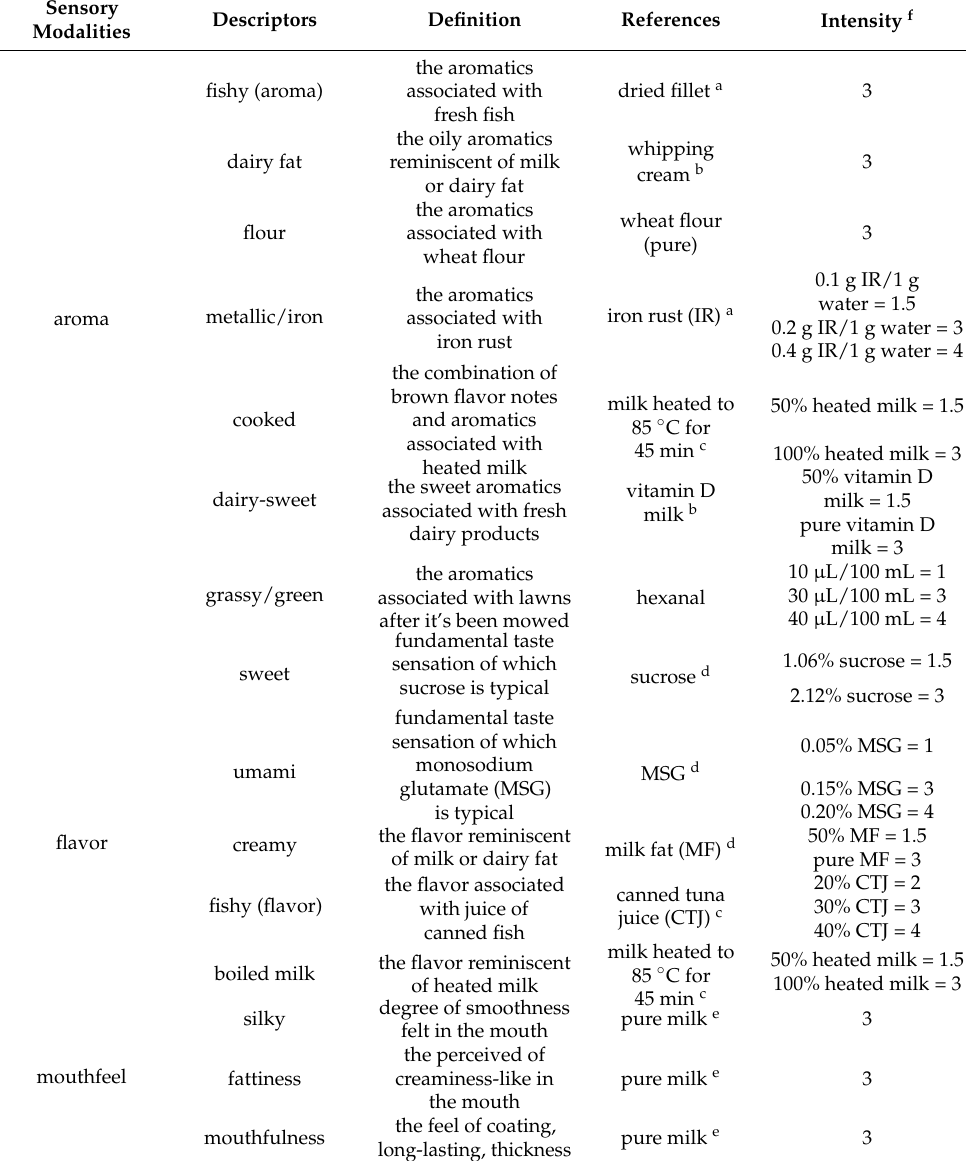
Table 3. Definitions, references, and the corresponding intensities of the selected sensory profile descriptors for human